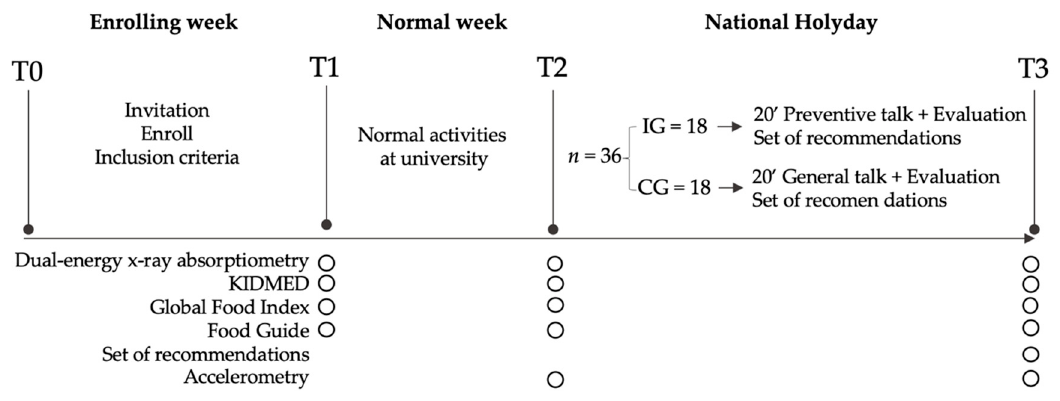
Figure 1. Study design; T: evaluation time; IG: intervention group; CG: control group; KIDMED: Mediterranean Diet Quality Index.